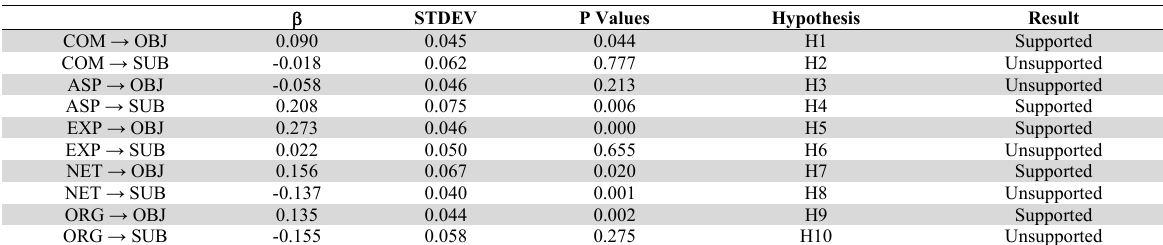
PLS-SEM results  STDEV P Values